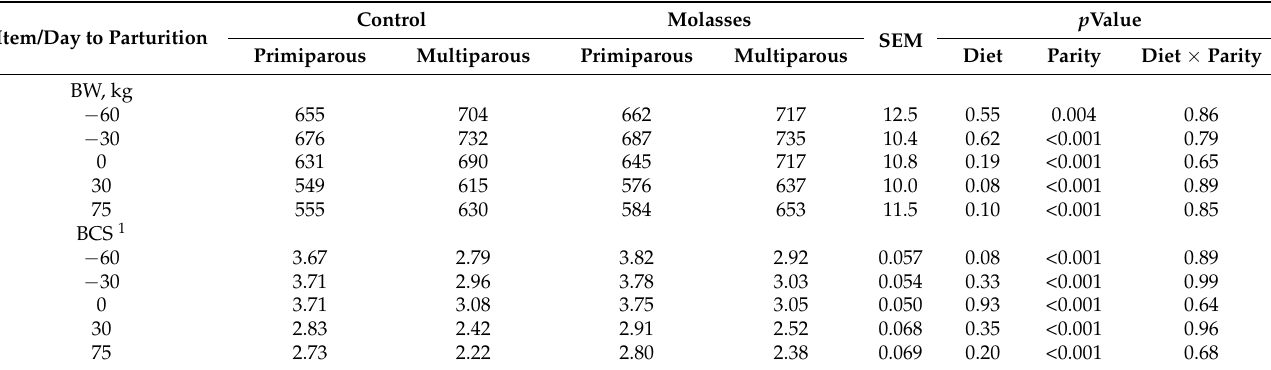
Table 4. Prepartum and postpartum body weight (BW) and body condition scored (BCS) of primiparous and multiparous cows fed control or molasses-containing diets during a 60 day dry period (Experiment 1).